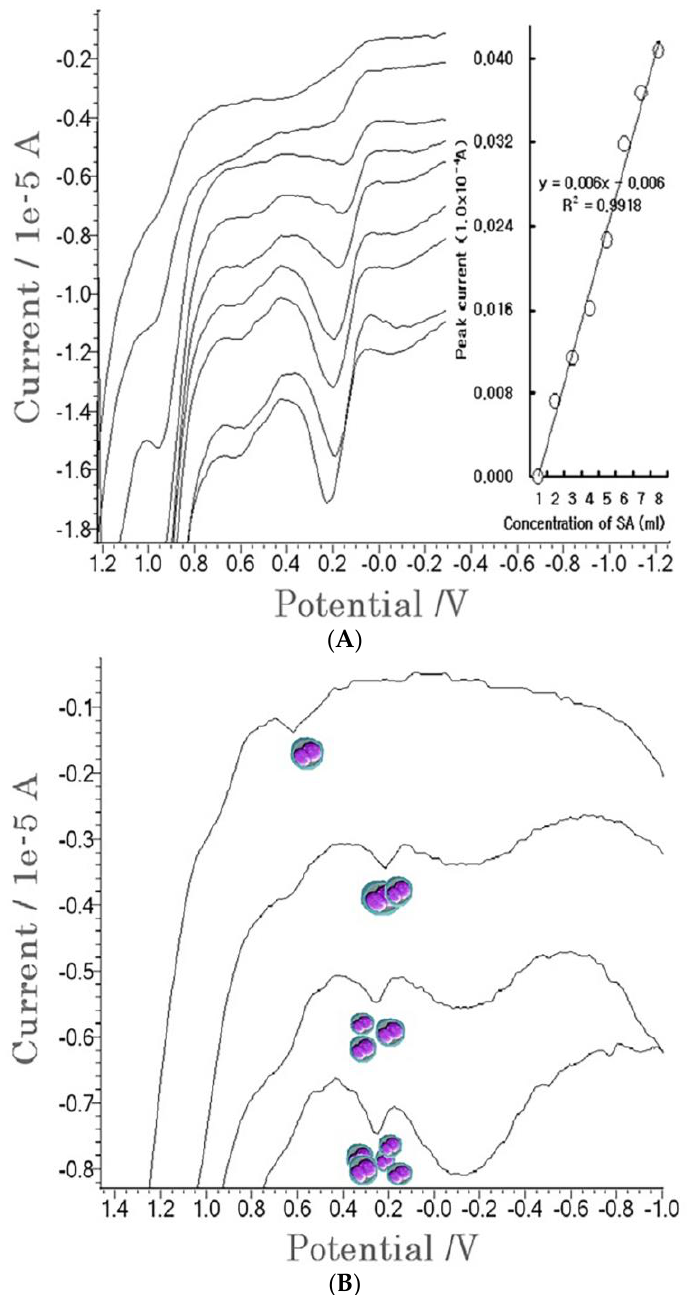
Figure 4. Positive patient test. ( A ) Anodic stripping for the 1.0 × 10 − ³ L patient sera, where the stripping conditions were 25 Hz frequency, 20 mV amplitude, − 2.0 V accumulation potential, 100 s accumulation time, and 20 × 10 − ³ V increment potential. ( B ) The standard addition methods used on the patients’ red cells, using the optimum SW conditions.